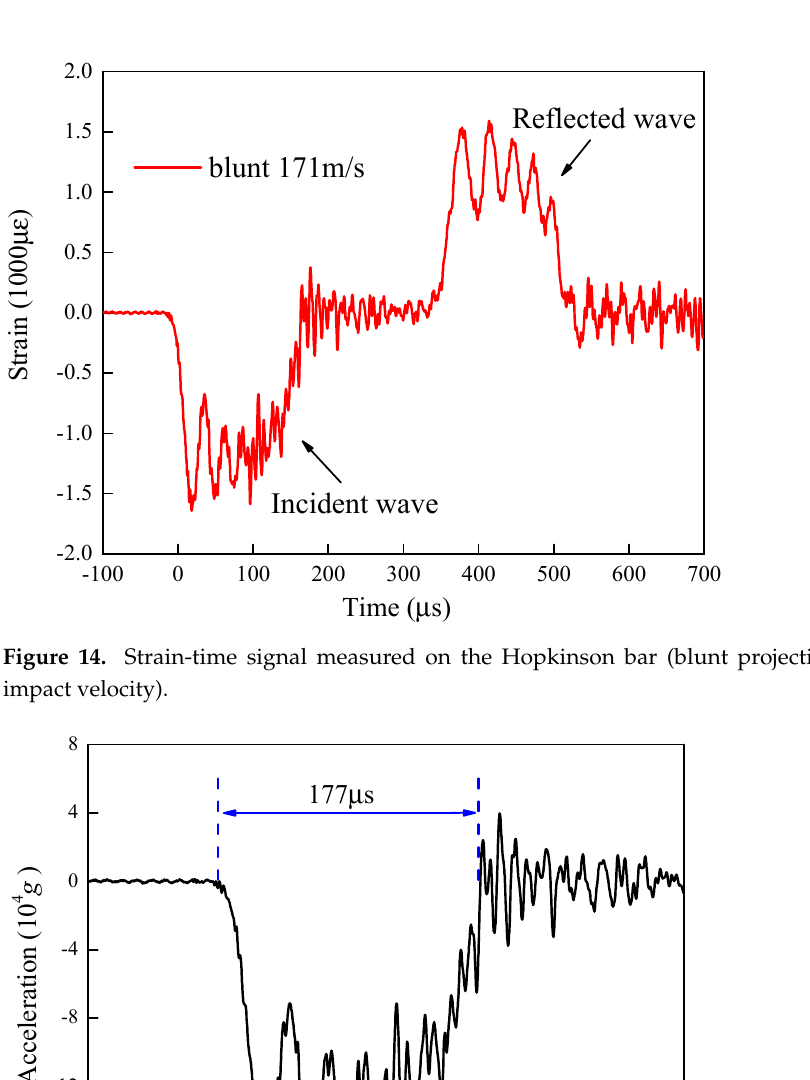
Figure 15. The maximum value in the curve was selected as the peak acceleration, the